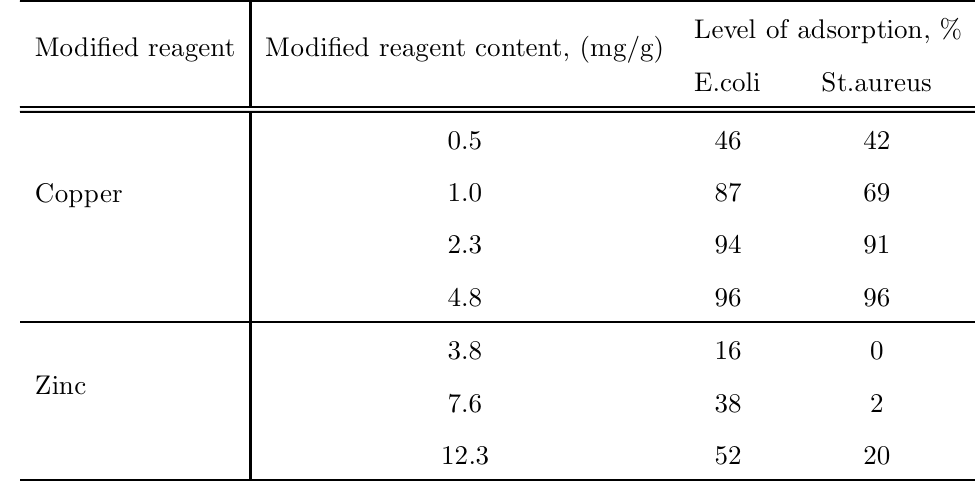
Table 7 Adsorption of microorganisms on silico-polimethylsiloxane (SG-PMS 50:50 wt%) mod- i› ed by Cu II and Zn II at pH